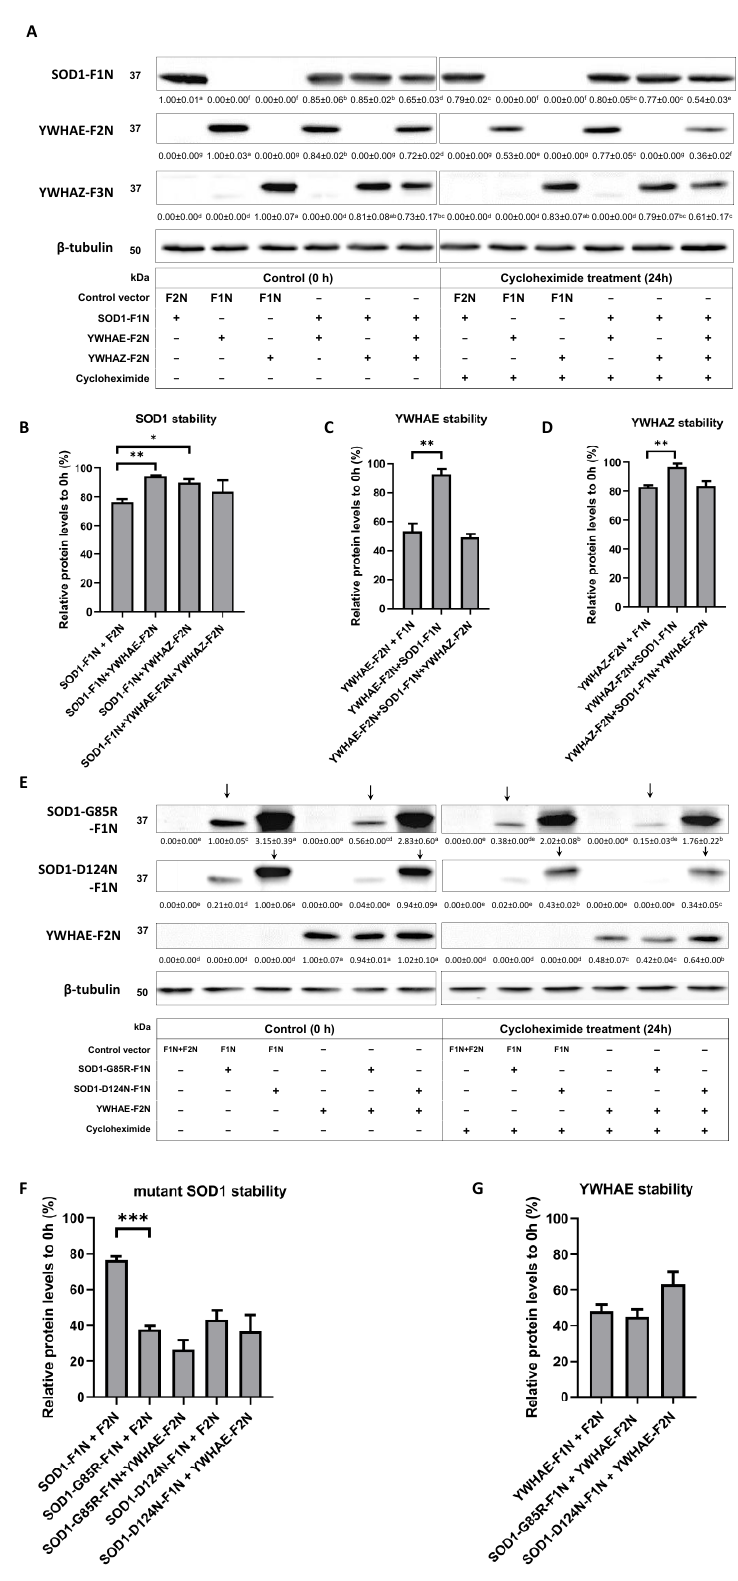
Figure 4. Effects of protein–protein interactions between YWHAE or YWHAZ with native and variant SOD1 proteins on their protein stability in HEK293T cells. ( A ) Immunoblots of protein stability